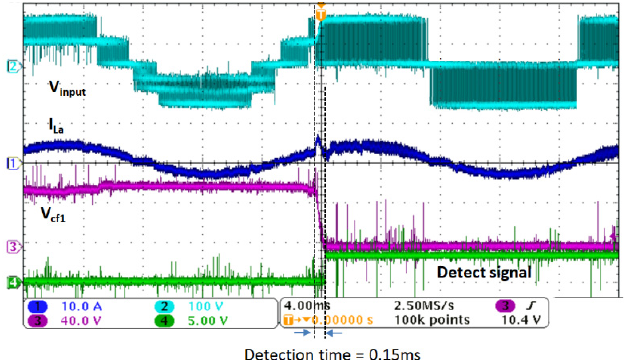
Figure 20. Experiment result for short-circuit fault condition on T 1 with the detection signal.